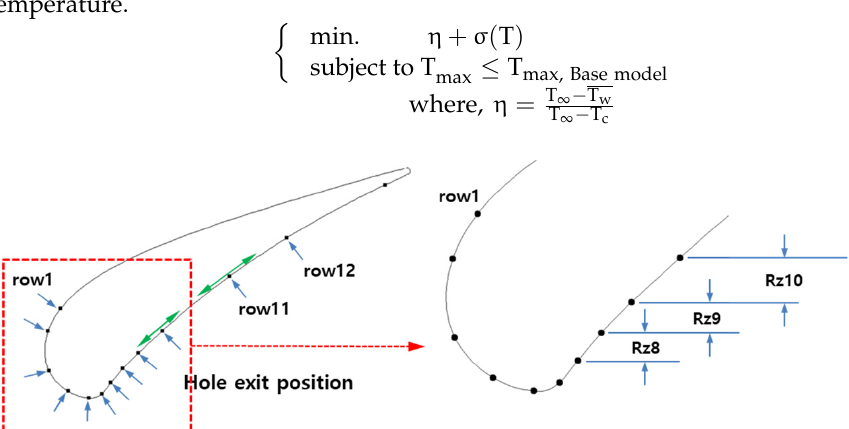
Figure 4. Definition of design variables (reprinted with permission from [16]; copyright 2021 Korean Society for Fluid Machinery). Table 1. Range of design variables (reprinted with permission from [16]; copyright 2021 Korean Society for Fluid Machinery).